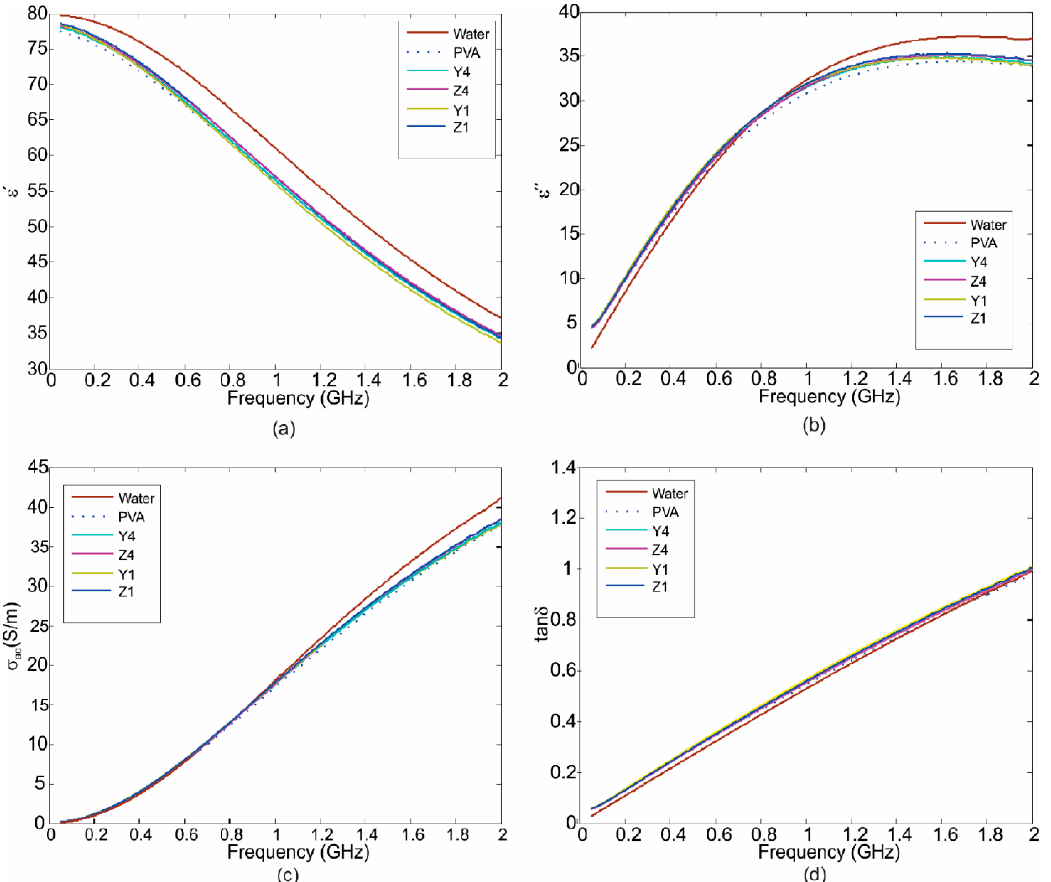
Figure 12. ( a ) The dielectric constant ( ε ); ( b ) loss factor ( ε ”); ( c ) conductivity ( σ in S/m); and ( d ) tan δ ; Figure 12 . ( a ) The dielectric constant ( ε ); ( b ) loss factor ( ε ’’); ( c ) conductivity ( σ in S/m); and ( d ) tan δ ; as a function of the frequency for various ZnO nanoparticles content in PVA as a function of the frequency for various ZnO nanoparticles content in PVA solution .